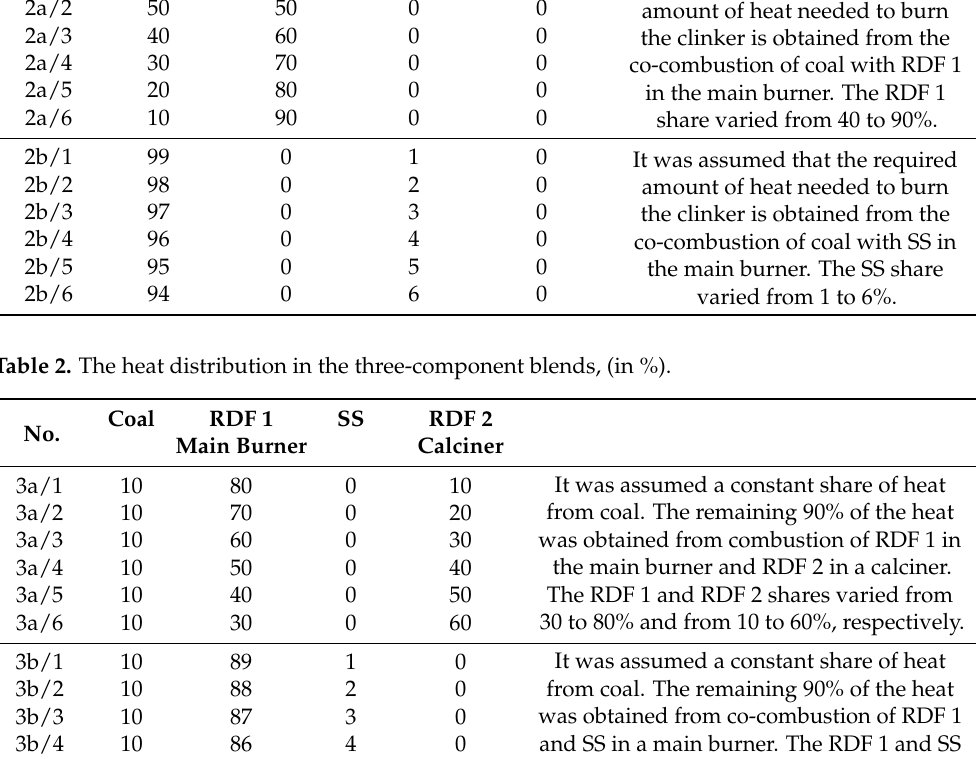
Table 2. The heat distribution in the three-component blends, (in %).